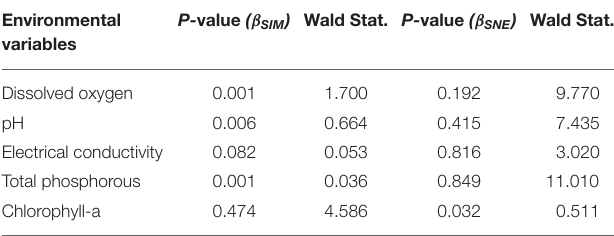
TABLE 1 | Monthly effects of the averaged Euclidean distances of the environmental variables on the components of the macroinvertebrate β -diversity partitioning, β SIM (species replacement) and β SNE (nestedness component), through multiple linear regression analysis. Environmental